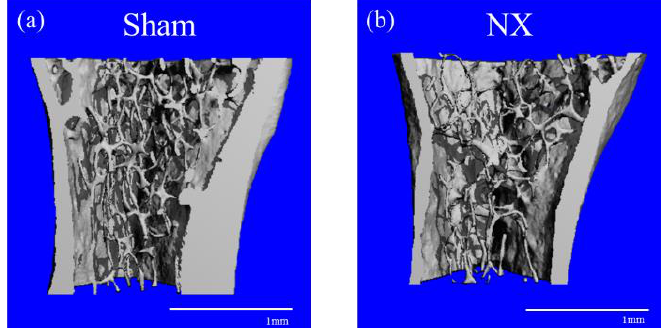
Figure 5. Volume rendering images constructed from X-ray micro-CT data of the proximal tibiae of ( a ) Sham and ( b ) NX mice. In the NX mouse, the thickness of the cortical bone is obviously decreased, and the microstructure of the cancellous bone is altered.